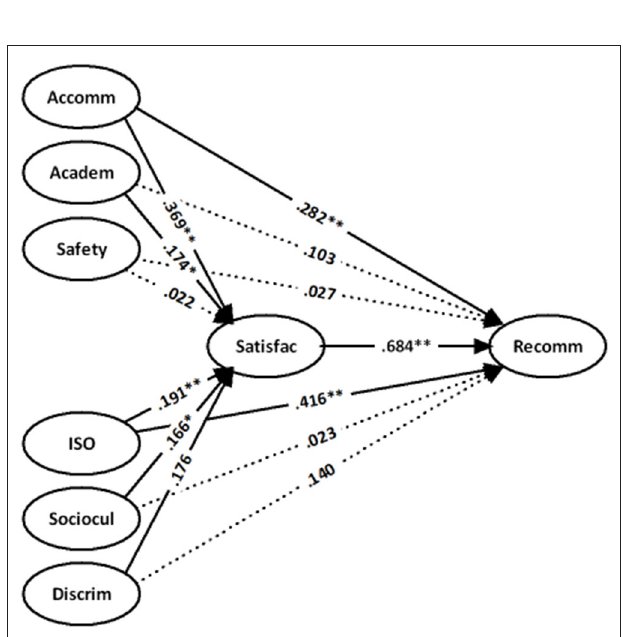
FIGURE 3 | Results for the Asian (country code = 2) sample with controls for gender and education.